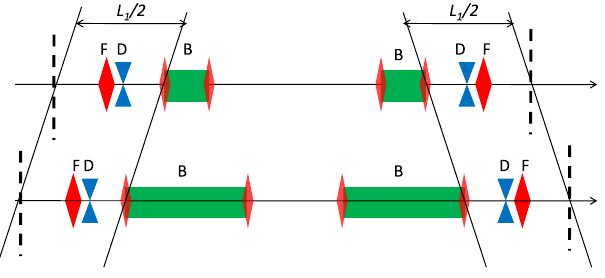
FIG. 9. Half lattice of RAFFIA (upper and lower: in an early/ middle stage of acceleration, respectively), where FD and DF are doublets and B represents the bending